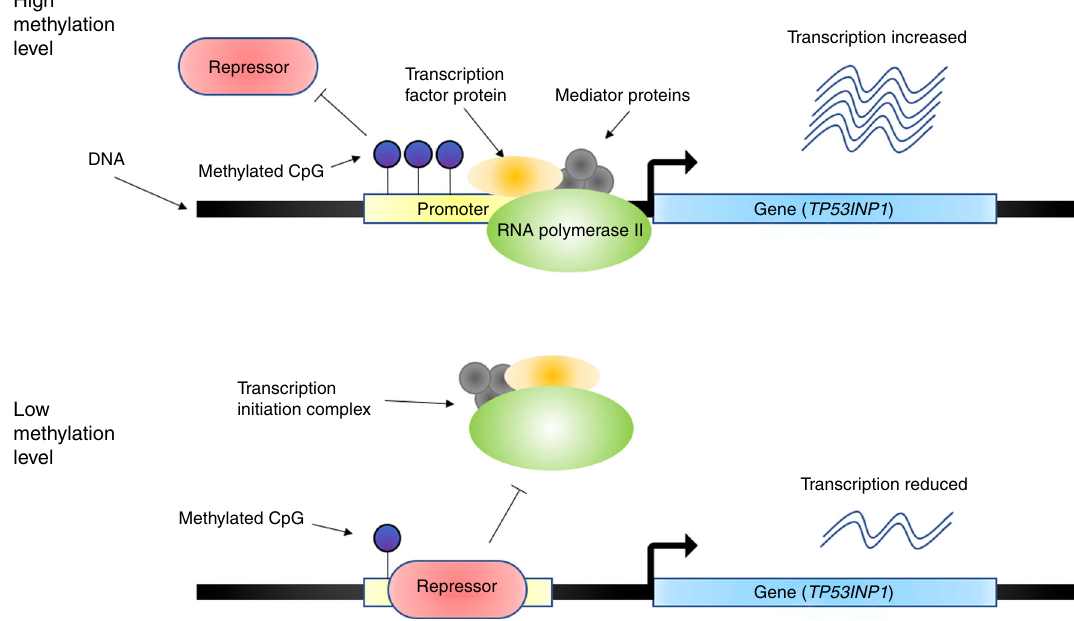
Fig. 5 Hypothesized regulatory mechanism at the TP53INP1 locus for T2D. When the promoter region is highly methylated, which prevents binding of repressor protein (red rounded rectangle) to the promoter region, RNA polymerase II (green ellipsoid), transcription factor protein (orange ellipsoid) and mediator proteins (gray circles) will form a transcription initiation complex that increases the transcription. However, when the methylation level of the promoter region is low, repressor protein can more ef fi ciently bind to the promoter, blocking the binding of the transcription initiation complex to the promoter, which decreases the transcription of